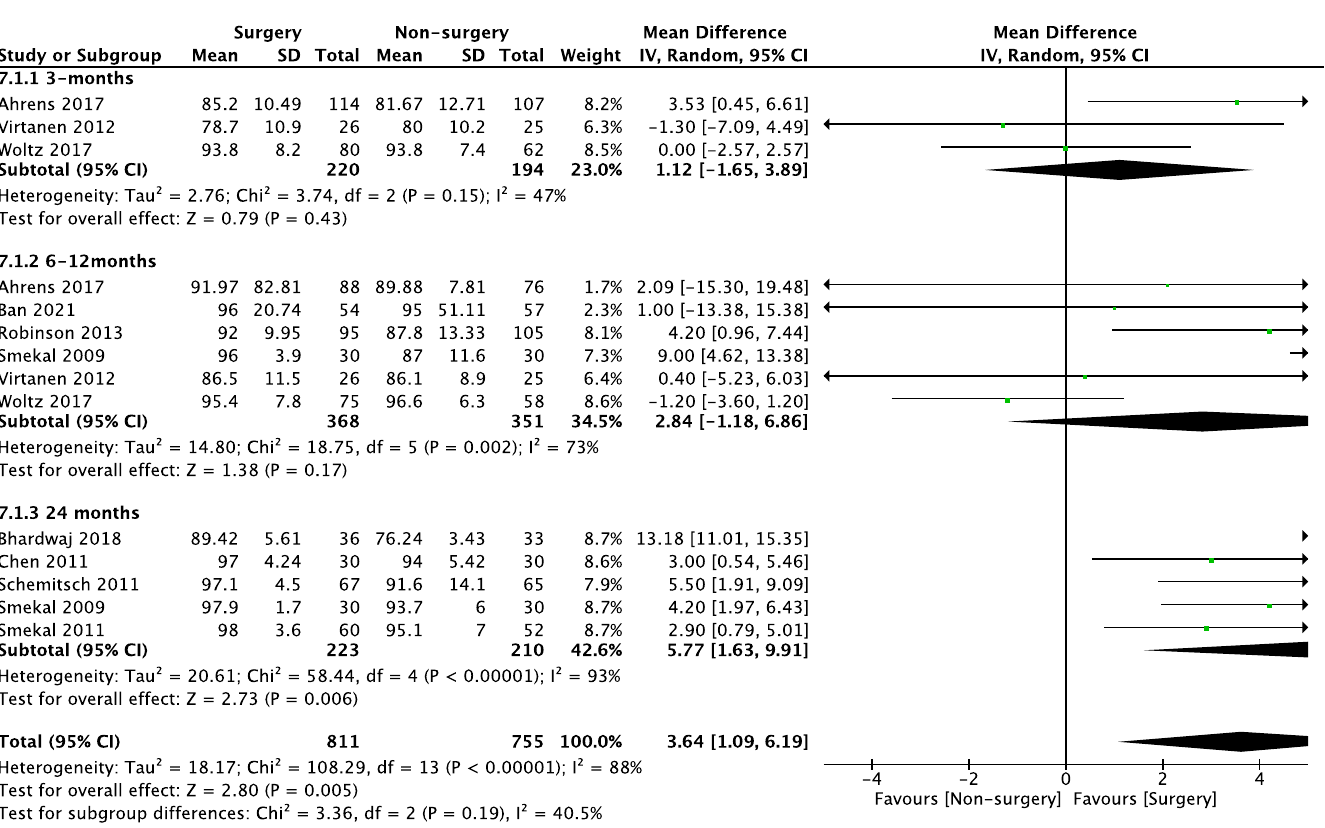
Fig 5. Meta-analysis of mean difference of CMS between surgical intervention and non-surgical intervention in the pooled studies. Overall, 3.64 (95% CI 1.09 to 6.19; p = 0.005) Early ( � 3-months) 1.12 (95% CI -1.65 to 3.89; p = 0.43); Intermediate (6–12 months) 2.84 (95% CI -1.18 to 6.86; p = 0.17); Late ( � 24 months) 5.77 (95% CI 1.63 to 9.91; p = 0.006).